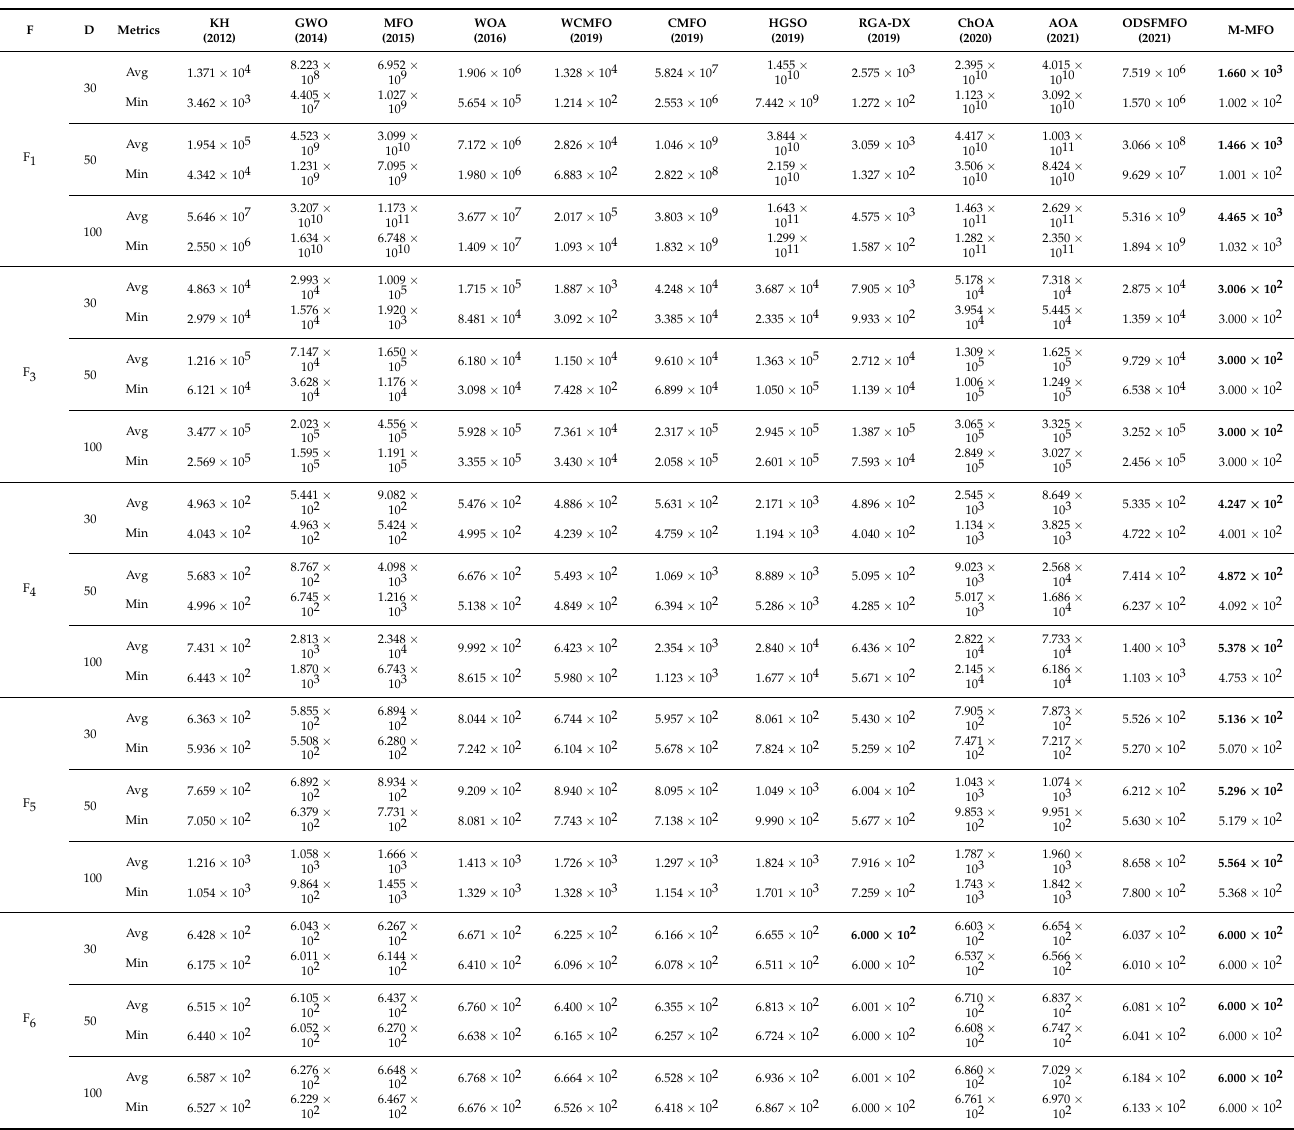
Table A2. Results of the comparative algorithms on unimodal and multimodal test